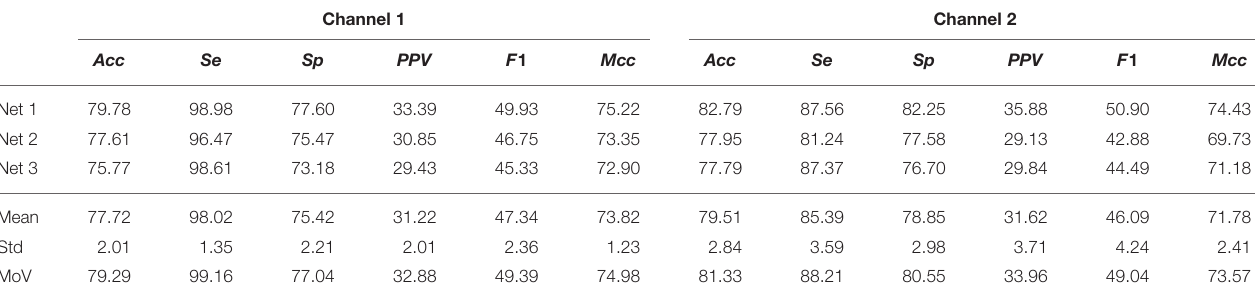
TABLE 5 | ECM-images classification performance on Arrhythmia